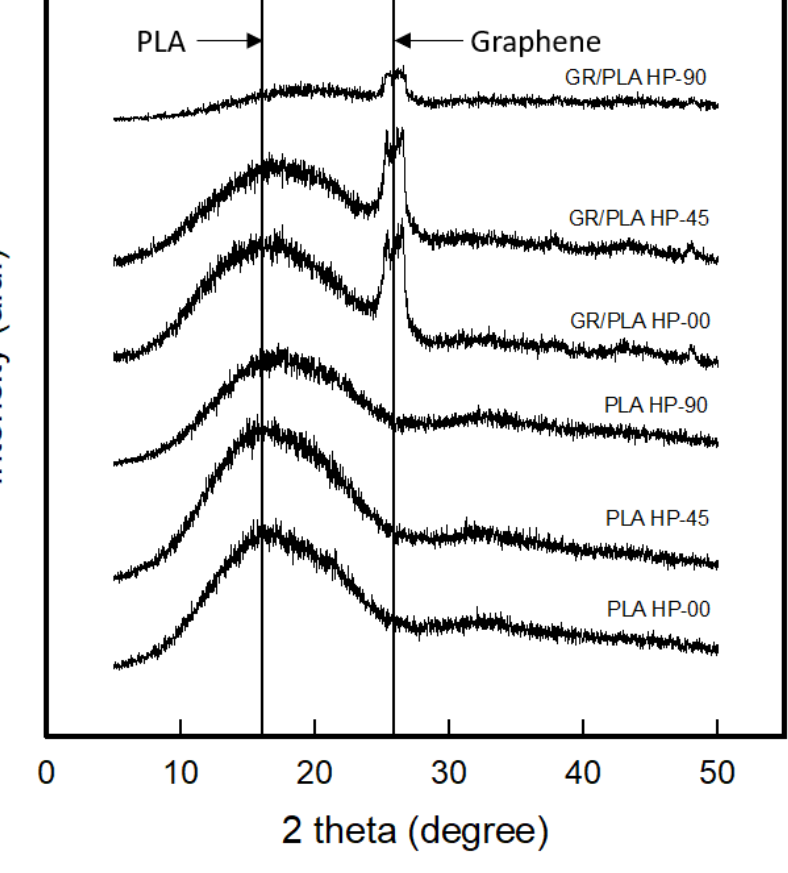
Figure 3. XRD patterns of conveyor-fused deposition modeling (CFDM) 3D-printed horseshoe pattern made with different 3D printing directions.